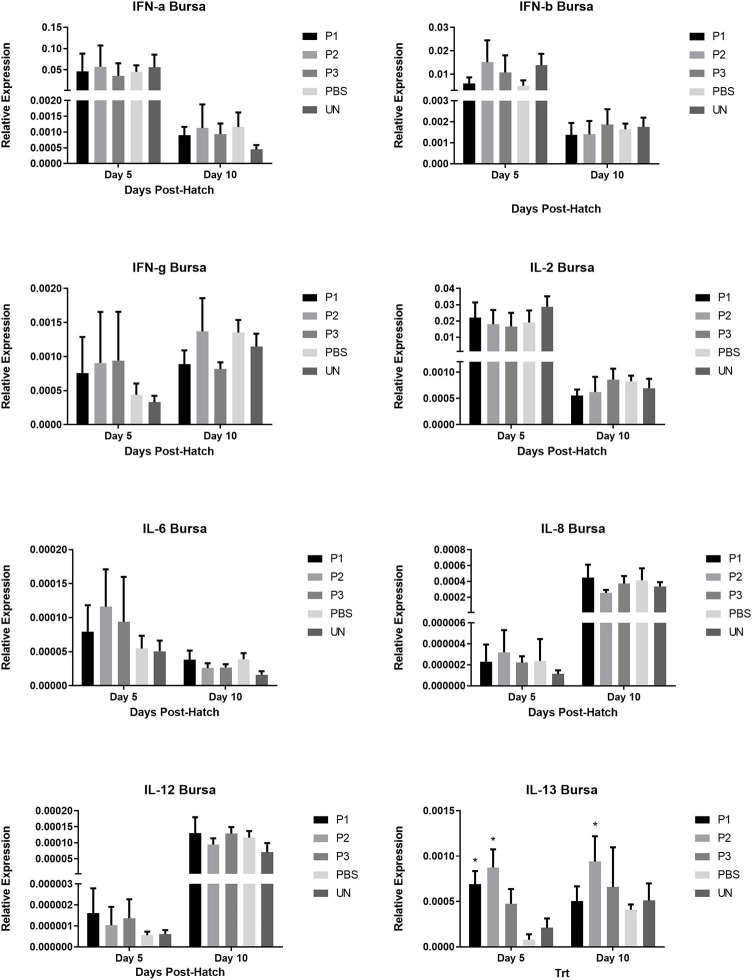
Relative gene expression of IFN-α, IFN-β, IFN-γ, IL-2, IL-6, IL-8, IL-12, and IL-13 in the cecal tonsils of chickens on days 5 and 10 post-hatch. Samples collected from 6 birds per treatment. Treatment groups were as follows: P1, P2, and P3 received 1 × 105, 1 × 106, 1 × 107 CFU/egg of a selected mixture of Lactobacillus bacteria (L. salivarius, L. reuteri, L. crispatus, and L. johnsonii) respectively (PBS, phosphate-buffered saline group; and UN, non-injected eggs). The reference gene (Beta-actin) was used for relative gene expression. Statistical significance among treatment groups was calculated using one-way ANOVA followed by Tukey's comparison test. Error bars represent standard errors of the mean. Results were considered statistically significant from the control group if P < 0.05. *Bars with asterisks differ significantly from control (PBS) group.